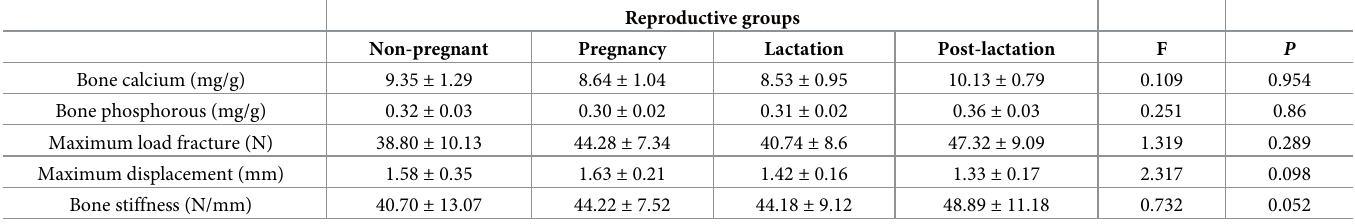
Table 2. Biochemical and bone strength parameters of reproductive female bats ( Artibeus lituratus